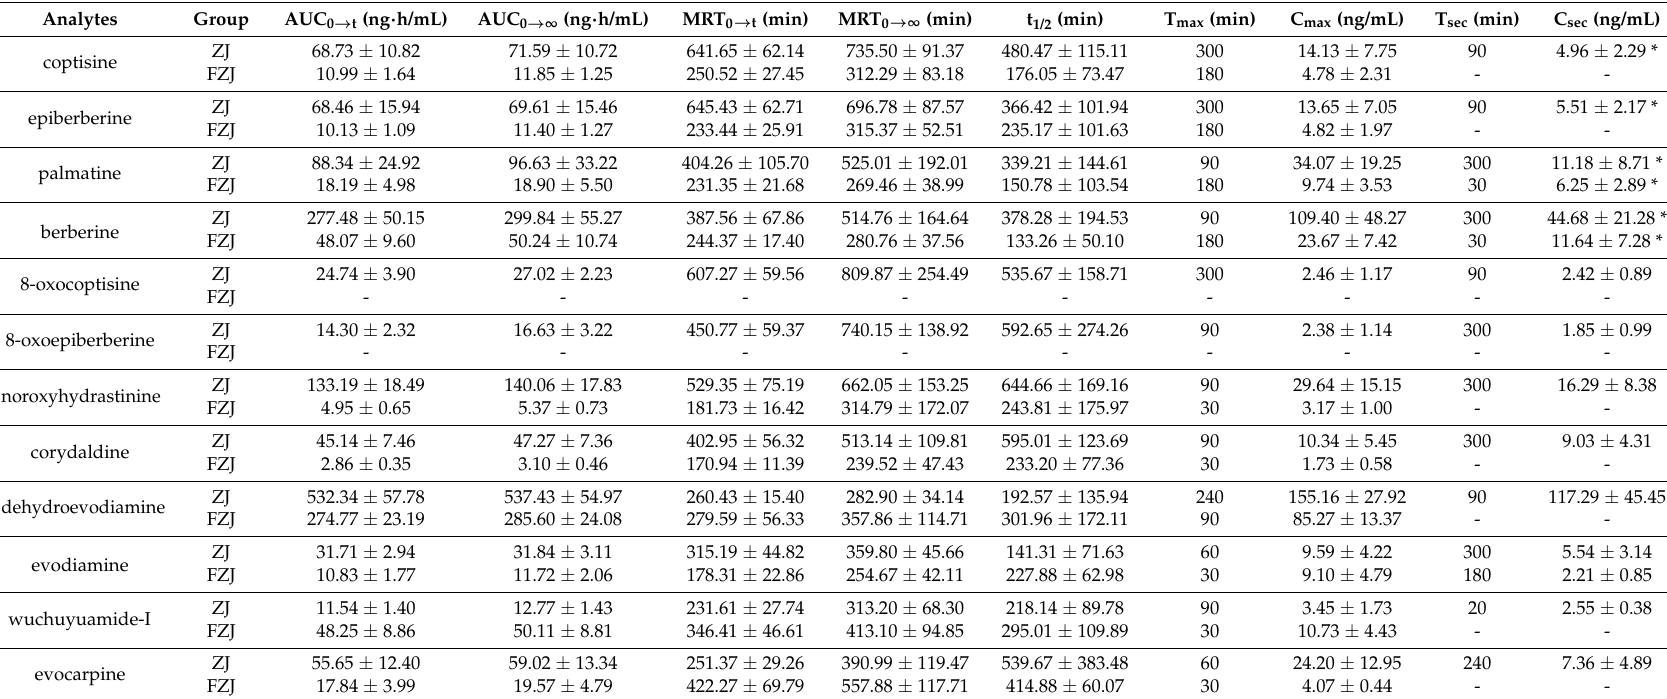
Table 1. PK parameters of the 12 alkaloids in rat plasma after oral administration of ZJ and FZJ extract (mean ± SD, n =